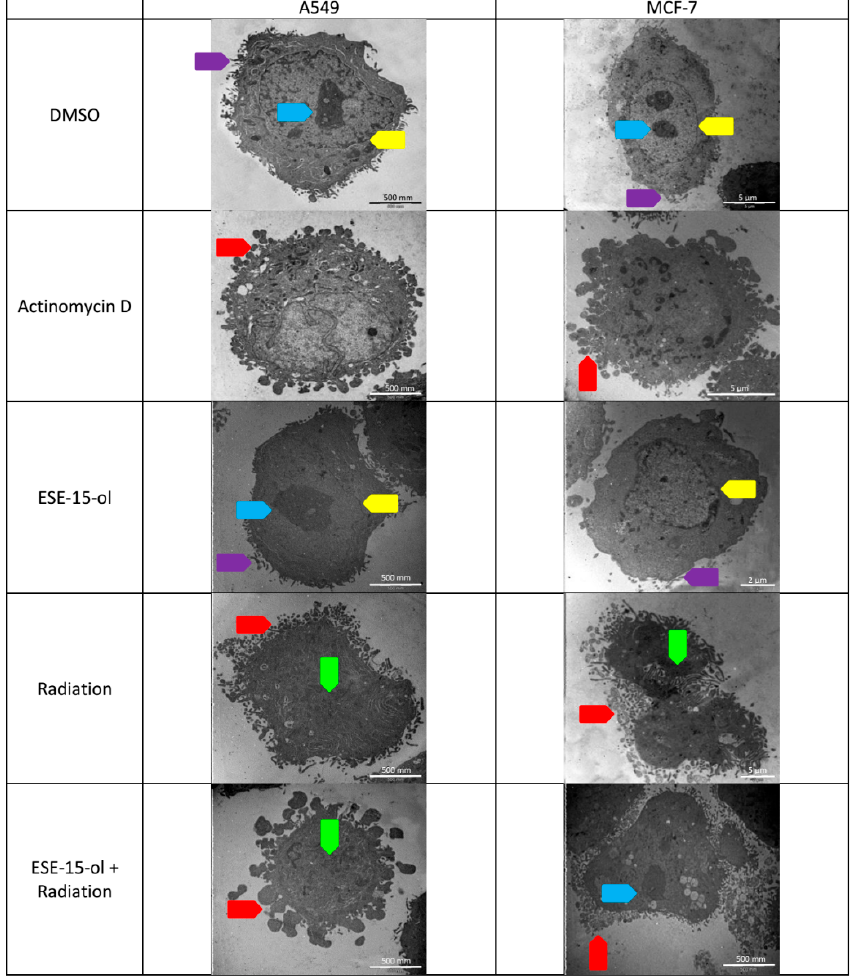
Figure 4. Transmission electron microscopy of A549- and MCF-7 cells. A549- and MCF-7 cells were exposed to controls and treatment conditions. Micrographs illustrate normal cellular protrusions (purple arrow), nucleoli (blue arrow), nuclear membrane (yellow arrow), hypercondensed chromatin (green arrow), and increased cellular protrusions (red arrow).